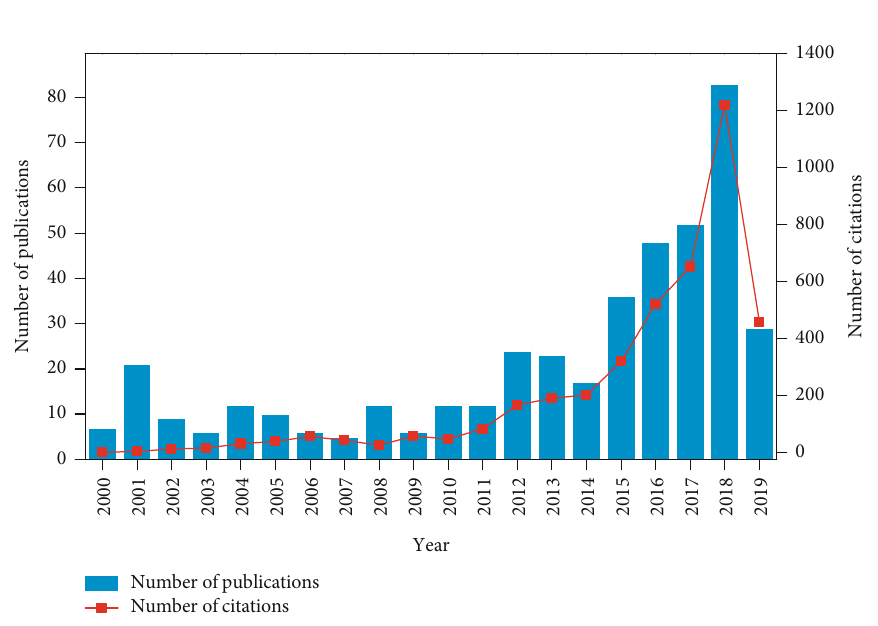
Figure 2: Color interpretation.